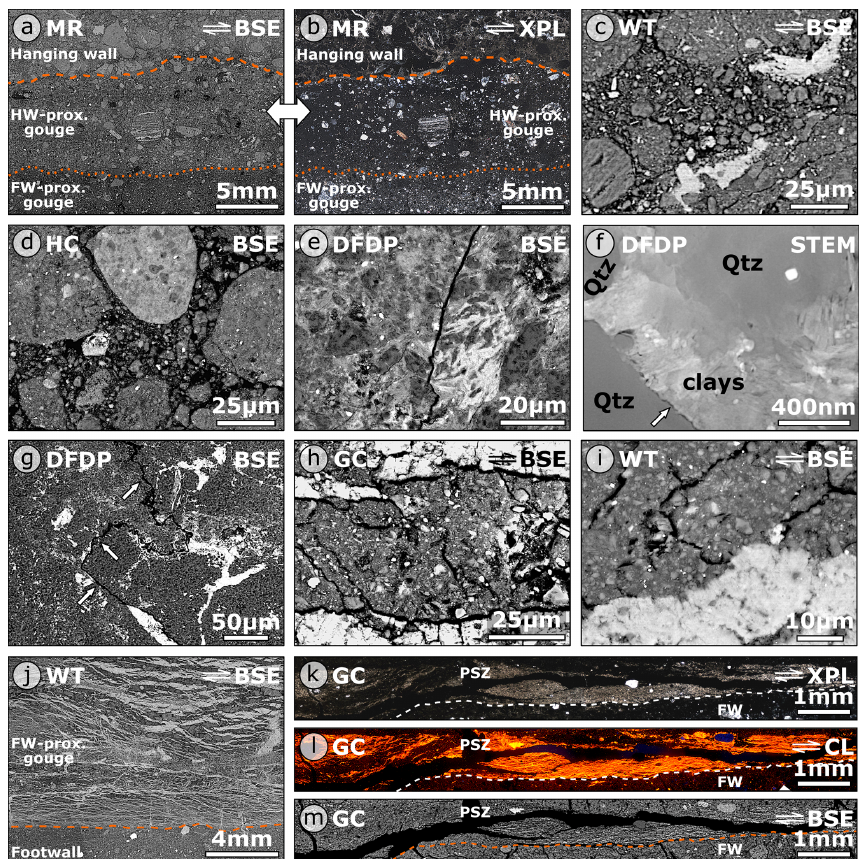
Figure 7. (a) BSE and (b) XPL photomicrographs of the fault core at Martyr River. Identification of the contact between the hanging wall and PSZ (stippled line) and that between the hanging wall- and footwall-proximal gouge (dotted line), respectively, is difficult. (c, d) The hanging wall-proximal gouge at Waikukupa Thrust (c) with its large amount of matrix clasts is microstructurally similar to the PSZ at Havelock Creek (d) . (e) Photomicrograph of typical microstructures of cemented PSZ at DFDP-1A core. (f) Cemented PSZ matrix of the DFDP-1A core. Pores between comminuted and dissolved (arrow) quartz grains are cemented by authigenic phyllosilicates, mostly chlorite. (g) Slickolite (white arrows) indicative of pressure solution. (h, i) Fault gouge at Gaunt Creek (h) is microstructurally similar to footwall-proximal gouge at Waikukupa Thrust (i) . (j) Network of anastomosing calcite veins within footwall-proximal gouge layer at Waikukupa Thrust. The contact between fault gouge and footwall (orange line) is sharp. (k, l, m) The basal part of the PSZ at Gaunt Creek hosts a network of calcite veins terminating at the sharp contact (white/orange stippled line) with the footwall (FW). MR: Martyr River; WT: Waikukupa Thrust; HC: Havelock Creek; DFDP: Deep Fault Drilling Project core 1A; GC: Gaunt Creek; BSE: backscatter electron microscopy; XPL: cross-polarized light; STEM: scanning transmission electron microscopy; CL: